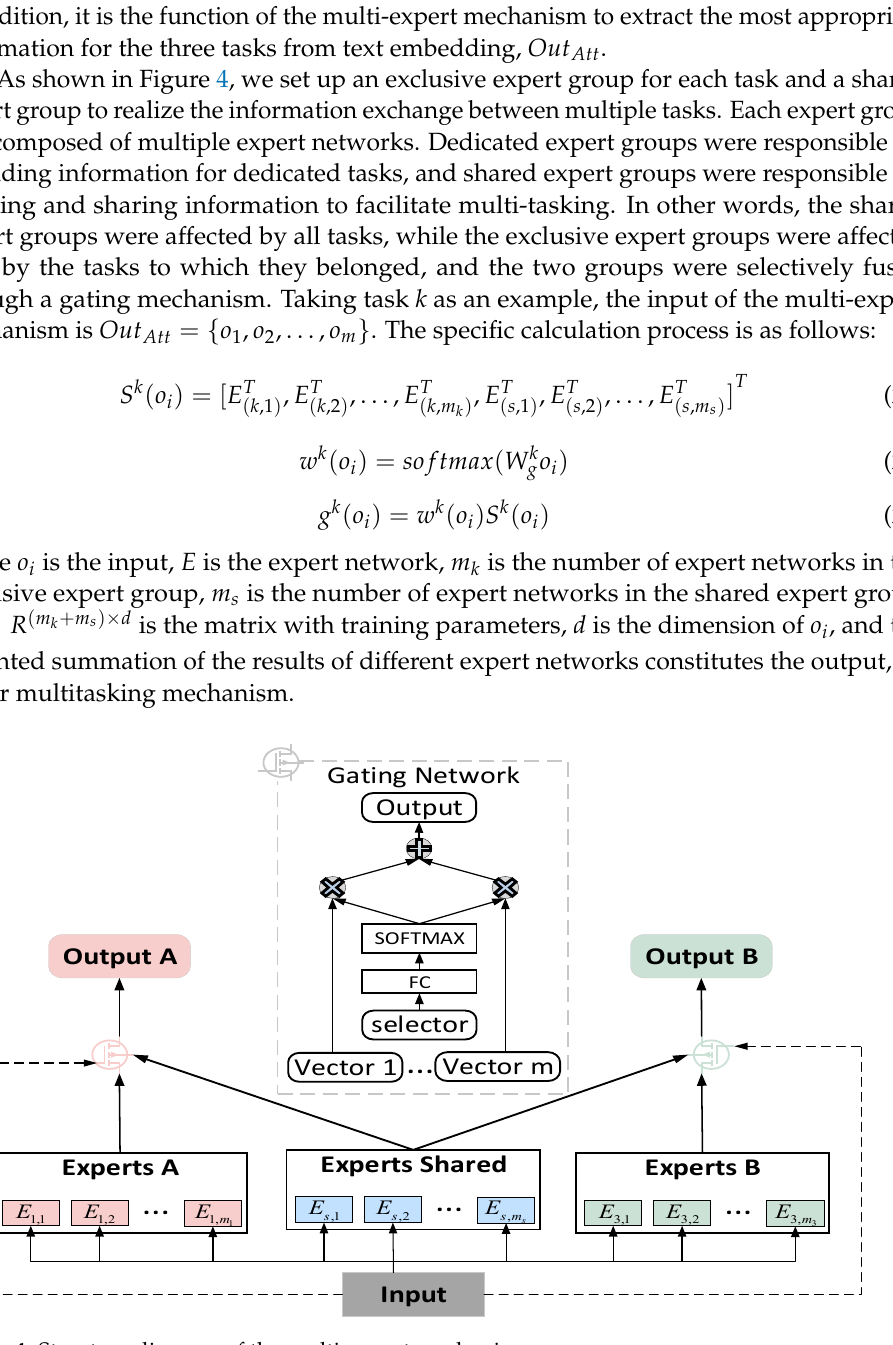
Figure 4. Structure diagram of the multi ‐ expert mechanism.